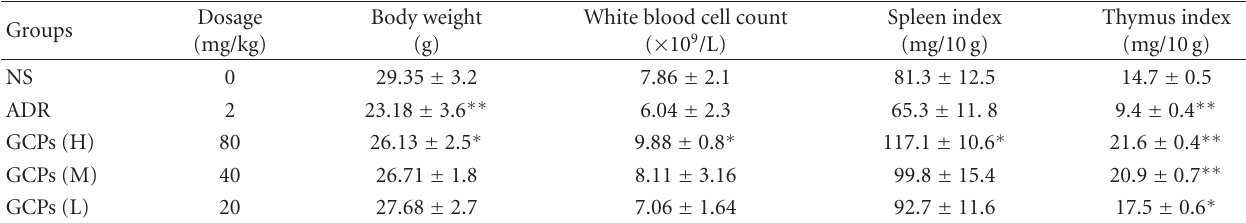
P < 0.05, ∗∗ P < 0.01 versus control.